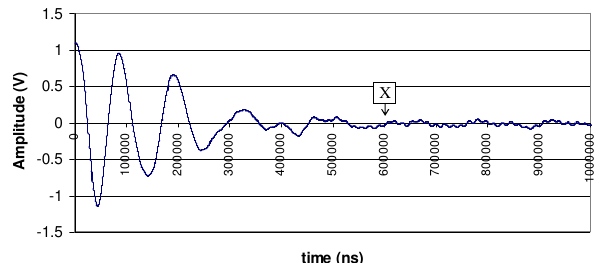
Fig. 3. Picoscope output of the sferic waveform (28 September Figure 3. Picoscope output of the sferic waveform. 2006, 18:01:04 LT–06:01:04 UT). (28/9/2006, 18:01:04 LT – 06:01:04 UT)